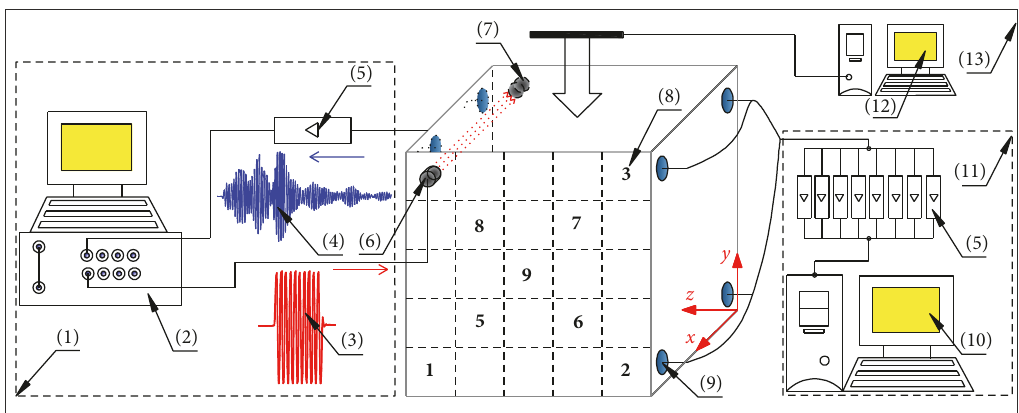
Figure 1: Diagram of the experimental system. (1) UT monitoring system. (2) ARB-1410 card. (3) Generated UT wave. (4) Received UT wave. (5) Preamplifier. (6) Generated UT probe. (7) Received UT probe. (8) UT test points. (9) AE sensor. (10) AE monitoring software. (11) AE monitoring system. (12) Loading system. (13) Shielded